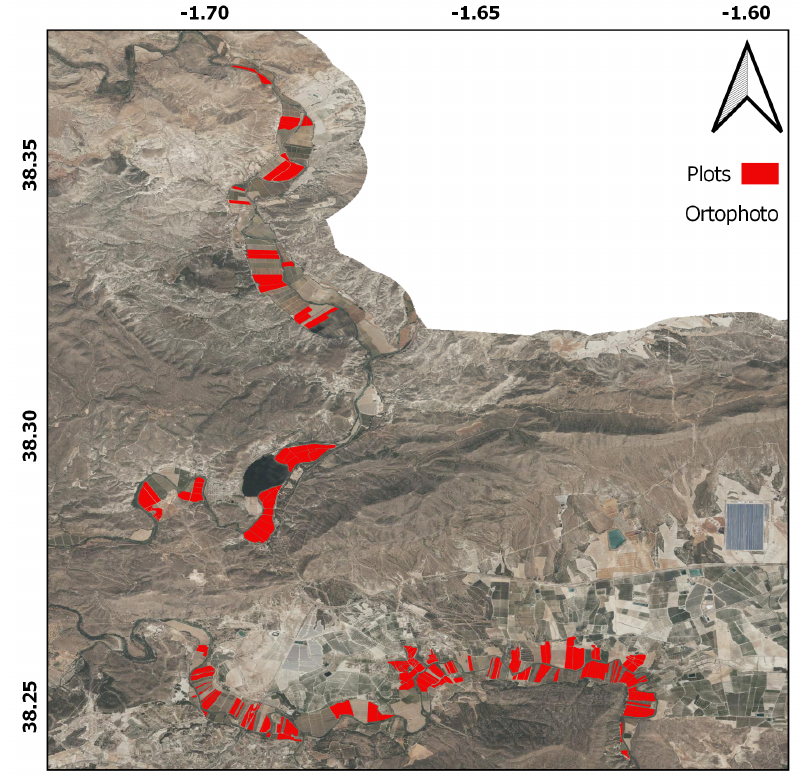
Figure 1. Plots located in Coto Arrocero, Calasparra (Murcia).